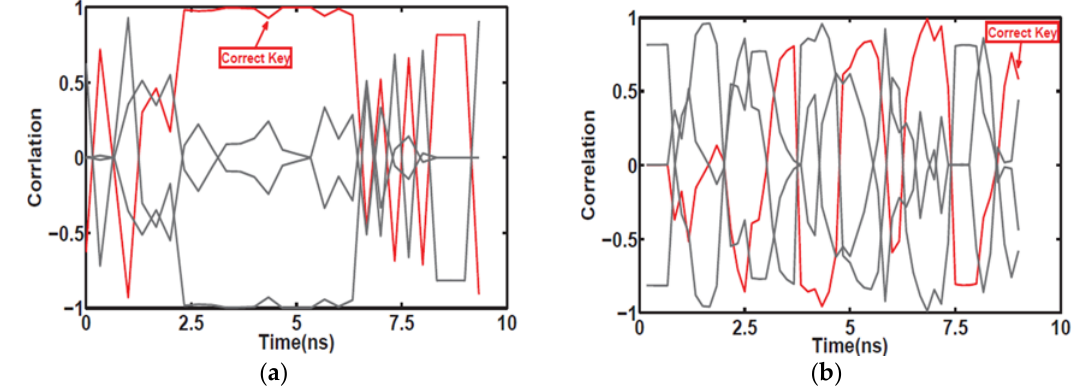
Figure 46. Correlation power analysis (CPA) attack on one clock cycle ( a ) TFET static KATAN32; ( b ) TFET CML KATAN32.